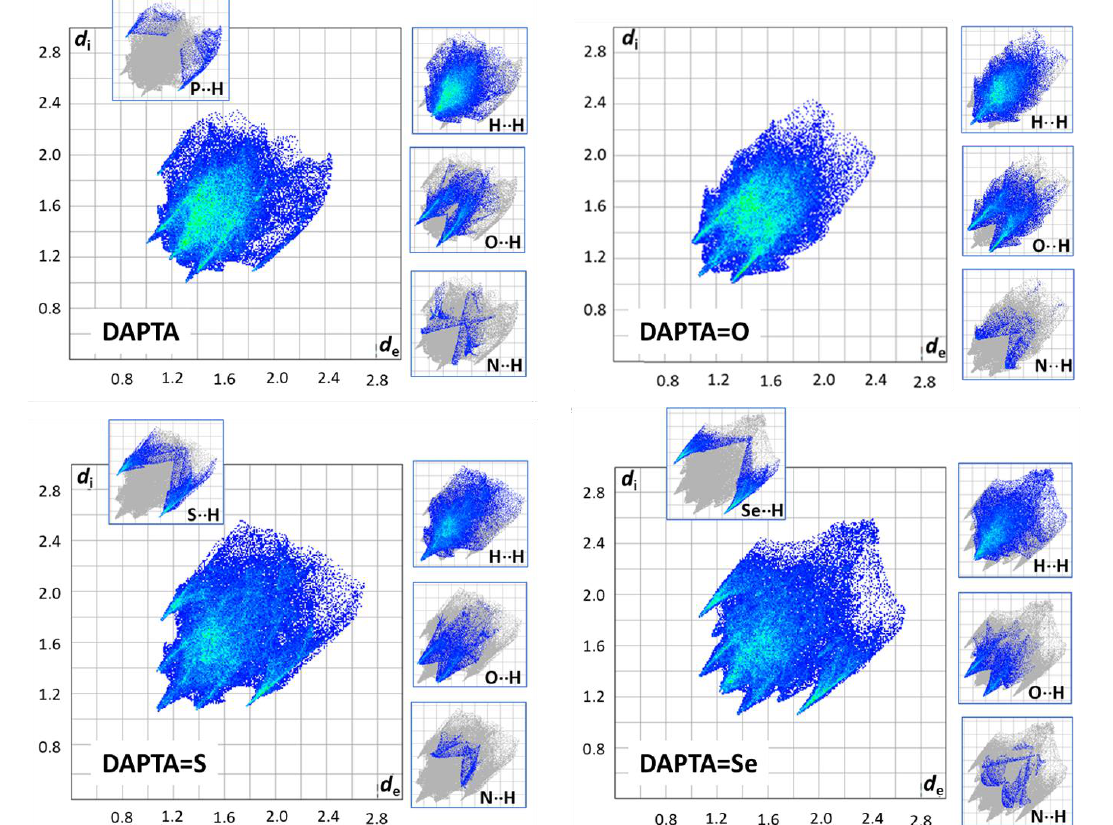
Figure 6. 2D fingerprint plots ( d i and d e values in Å) for DAPTA and P-functionalized derivatives. The offset plots refer to the indicated specific interactions.